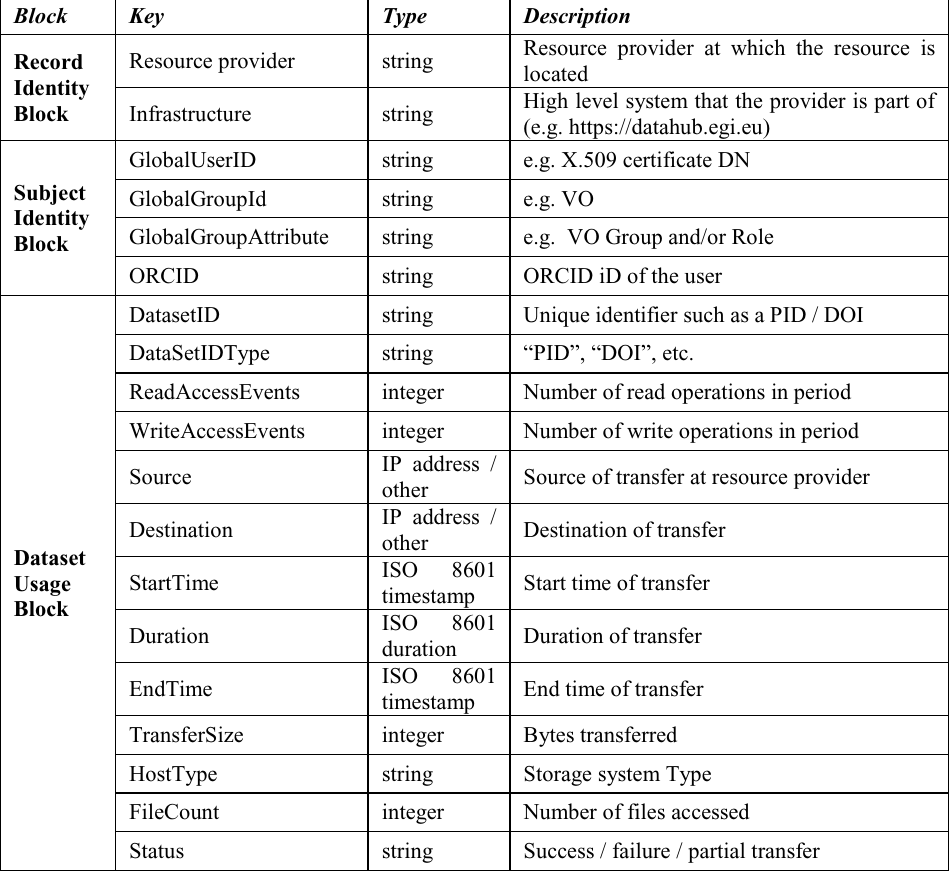
Table 1 Metrics used in the final